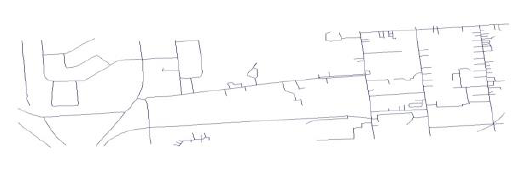
Figure 9. Ground truth